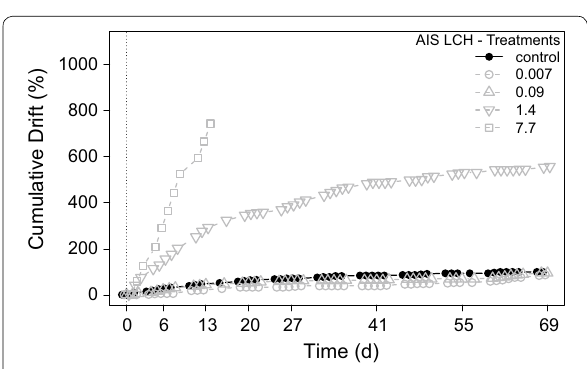
Fig. 9 Cumulated overnight drift activity of grazers during the LCH experiment. All LCH treatments in µg g − 1 OC